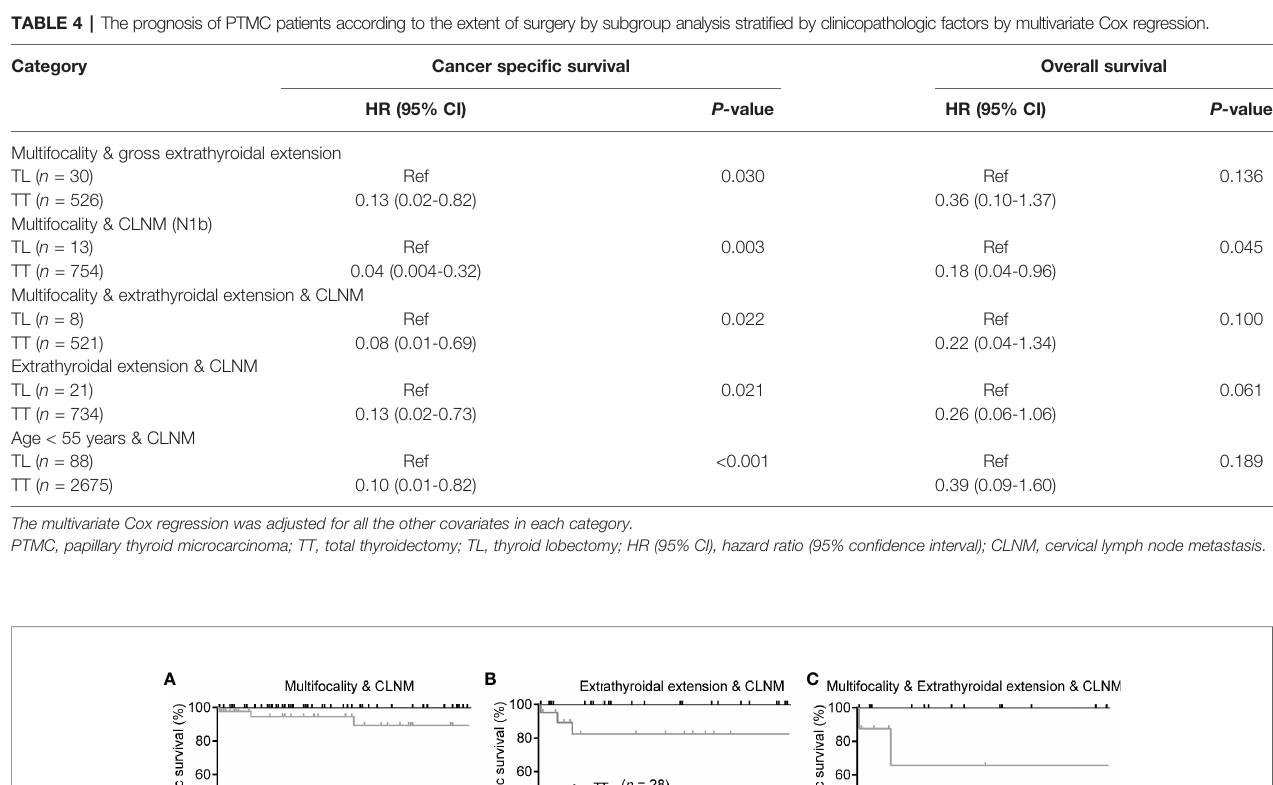
The multivariate Cox regression was adjusted for all the other covariates. PTMC, papillary thyroid microcarcinoma; TT, total thyroidectomy; TL, thyroid lobectomy; HR (95% CI), hazard ratio (95% con fi dence interval); CLNM, cervical lymph node metastasis; RAI,